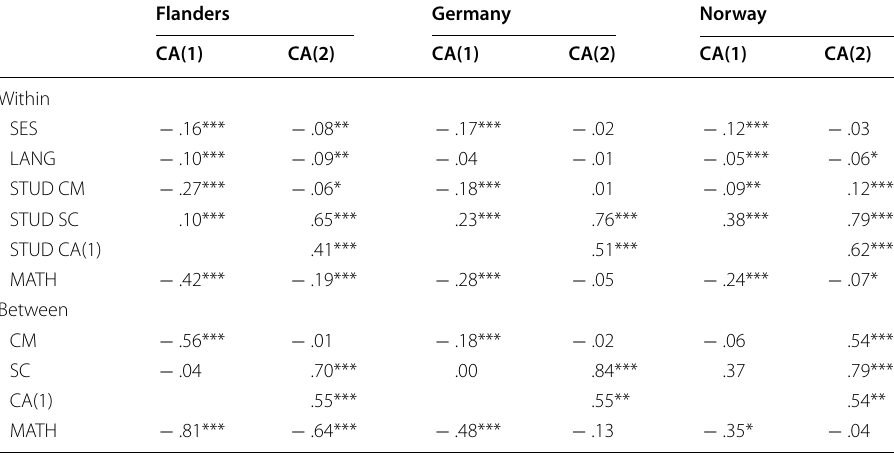
Table 3 Correlation of the two components of CA with the other variables